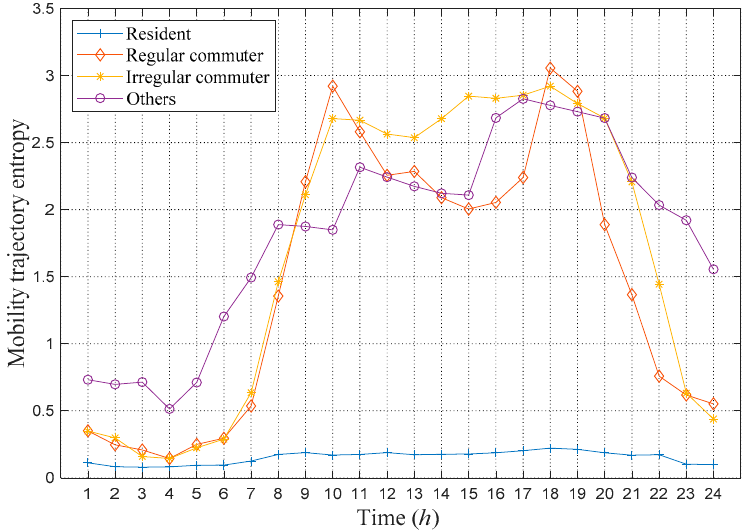
Figure 2. Average MTE in every hour of the four types of users.